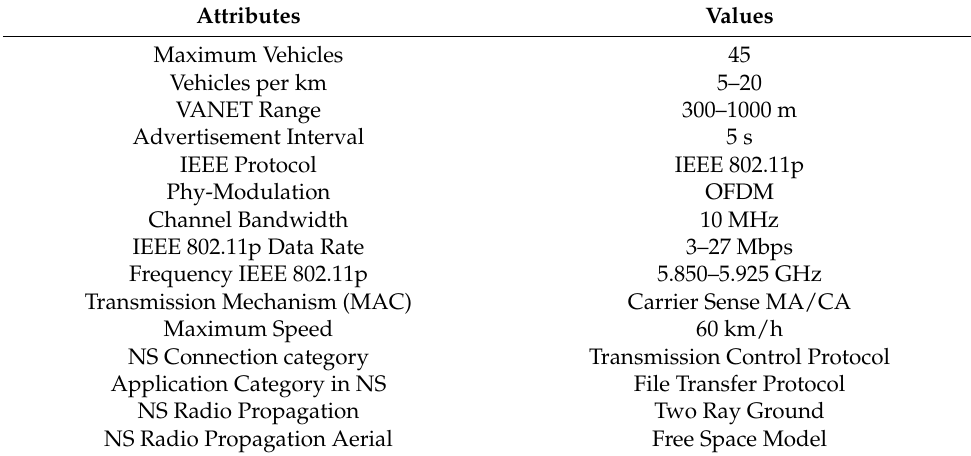
Table 2. UGAVs-MDVR simulation